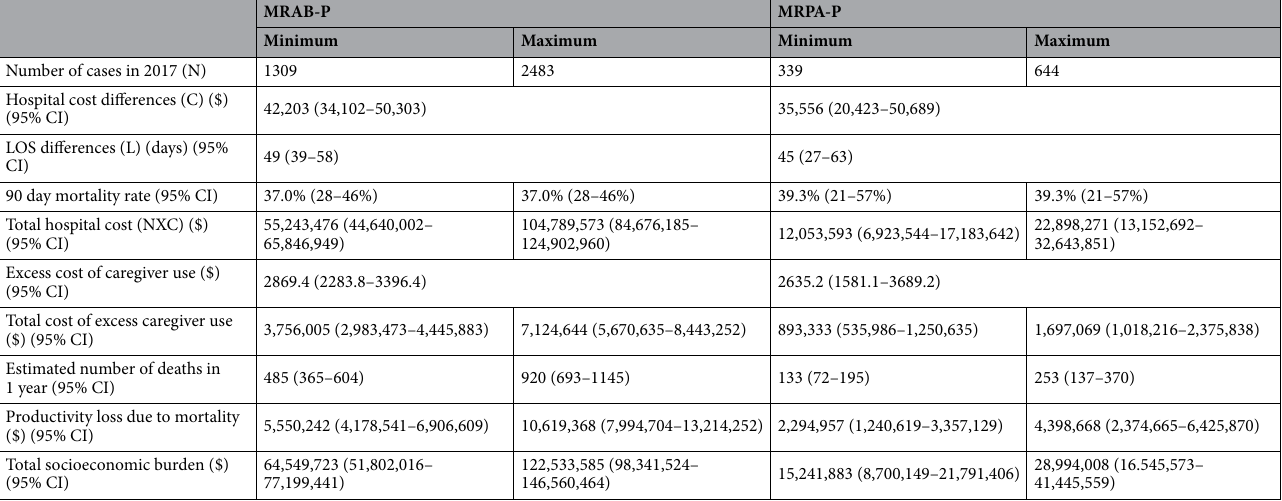
Table 4. Results of socioeconomic burden estimation of two multidrug-resistant organisms’ pneumonia. MRAB-P multidrug resistant A. baumannii pneumonia, MRPA-P multidrug resistant P. aeruginosa pneumonia, CI confidence interval, LOS length of